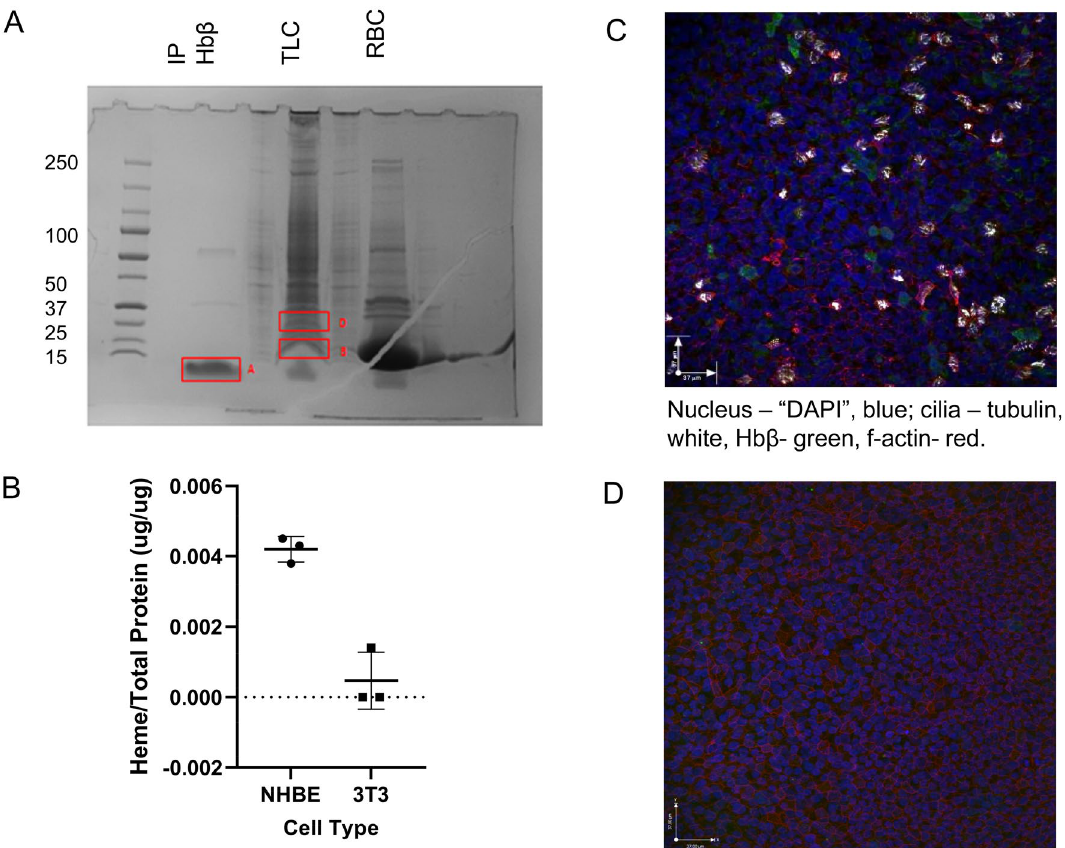
Figure 2. Heme proteins in human airway epithelial cell cultures were detected by immunoblot, immunofluorescence and by LC–MS proteomics. ( A ) Hbβ was immunoprecipitated (IP Hbβ) and run with total lysate from cells (TLC) and whole erythrocyte lysate (RBC) on an SDS gel, followed by Coomassie blue staining. Three bands were excised from the immunoprecipitated Hbβ (IP Hbβ) band and TLC for LC–MS. LC–MS analysis of the samples reveals: Band A: Hbβ, Hbδ, Hbα, Protein S100-A6. Bands B and D: Hbβ, Hbδ, Hbα and other proteins. ( B ) Airway cell proteins have bound heme . Drabkin reagent (Sigma, # D5941) was used to determine average amount of heme/total protein 15 . Three normal primary human airway epithelial cell samples, consisting of 10–12 filter each scraped in RIPA buffer, were lyophilized and reconstituted in Drabkin reagent. Heme was measured with absorbance (λ = 540 nm) by spectrophotometer. The fibroblast NIH 3T3 cells were used as a control. ( C ) Immunofluorescent staining of primary normal human airway epithelial cells grown for 35 days at ALI, then fixed, permeabilized and labeled as described in the methods, confirmed expression Hbβ in HBE cells (top). (Nucleus—DAPI, blue; cilia—white, HBβ-green, f-actin red). ( D ) Isotype control IgG (for the anti-Hb Ab) in cells grown identically to those in 2D served as a negative ALI are clustered by gene expression profiles into cell types. Ciliated cells are shown in yellow-orange (Fig. 1C), where Hbβ is also strongly expressed (Fig. 1D). Hemoglobin α1 mRNA and hemoglobin α2 mRNA were also expressed, but much less than Hbβ, and very little were present in ciliated cells (Fig. 1E, right and left). To determine whether the gene expression data were reflected in protein expression, we performed a number of experiments. In the airway epithelial immunoprecipitate, most of the Hb β is monomeric, but there are faint trimer and tetramer bands as well (Fig. 2A). In the erythrocyte lysate, the majority is dimeric . To analyze this further, we performed IP and Coomassie staining on the proteins and cut out the Hb band for LC–MS proteomic analysis. Hb α, β, and δ proteins were expressed in human airway pseudostratified epithelial cultures (Fig. 2A). Note that heme was also present in human airway epithelial cells at ALI: concentrations were substantially higher in NHE cells (heme amount 0.0042 ± 0.00035 μg/μg protein) than in NIH 3 T fibroblasts (0.00047 ± 0.00083 ug/ ug protein), (Fig. 2B). Note that heme could have been incorporated into non Hb proteins in airway epithelial cells. Finally, Hbβ was also expressed in ciliated cells detected by immunohistochemistry in NHE cells (Fig. 2C); Fig. 2D is a negative control for IHC Hbβ.